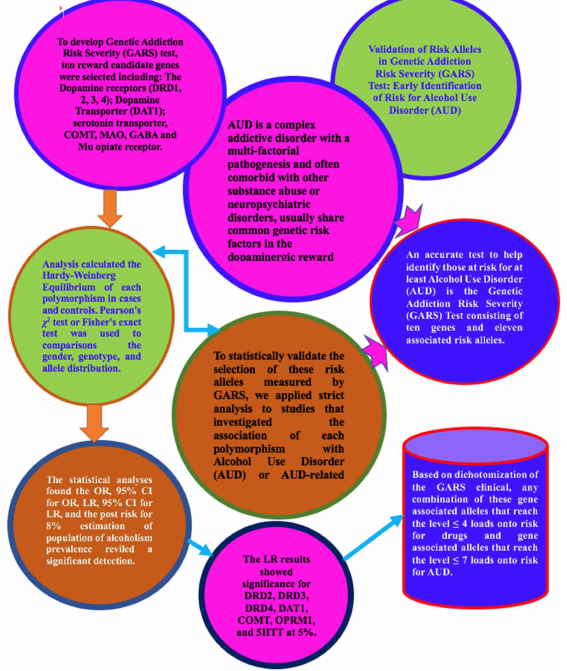
Figure 2. Schematic of statistical validation of risk alleles in genetic addiction risk severity (GARS) test: Early identification of risk for Alcohol Use Disorder (AUD) in 74,566 case-control